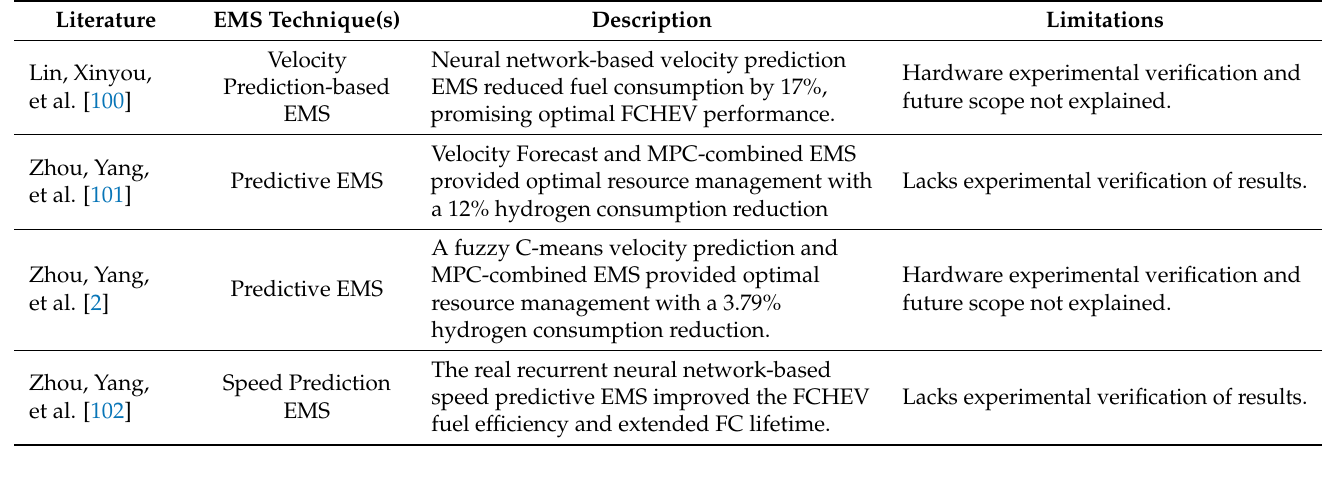
Table 10. Summary of the latest literature related to driving cycle prediction EMSs.